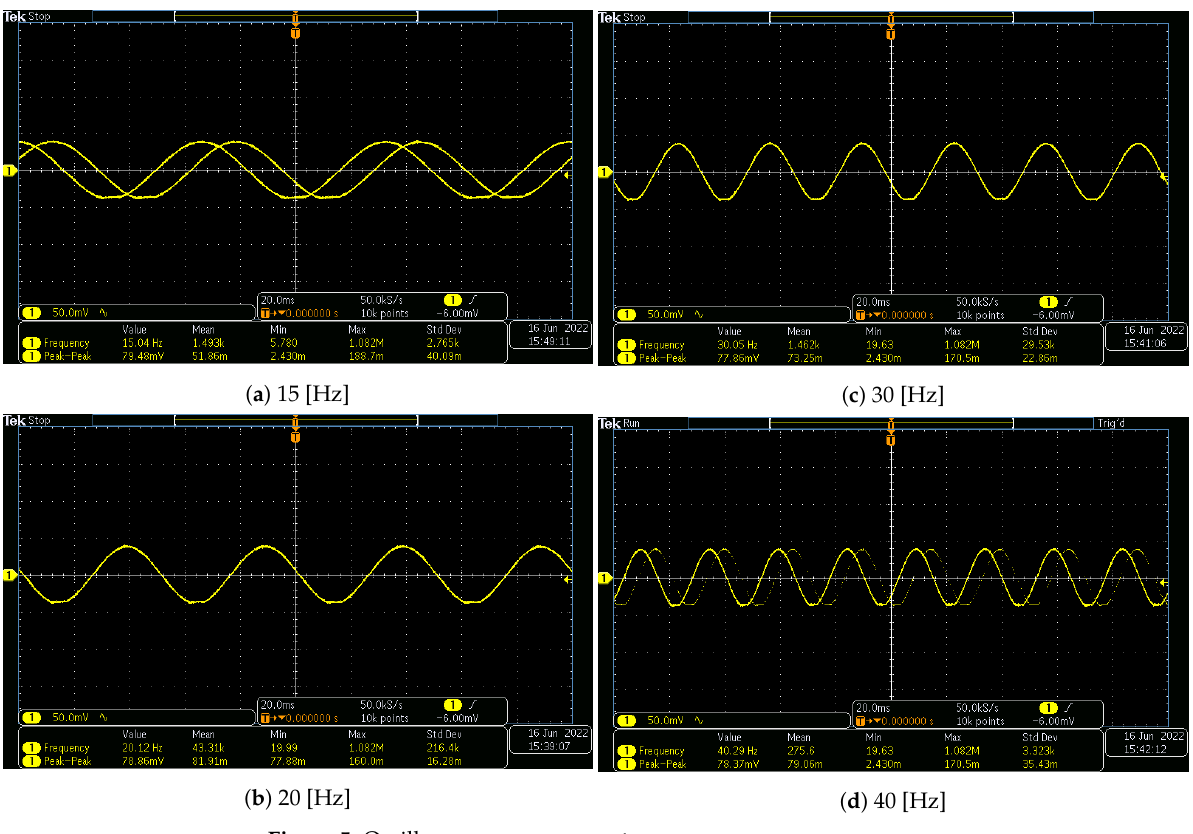
Figure 4. Implemented results.